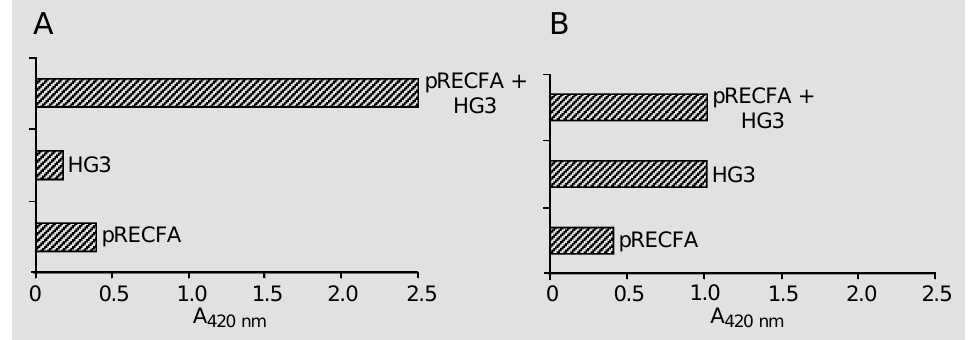
Figure 2 - CFA/I-specific se- creted IgA (sIgA) antibody re- sponse in fecal extracts from mice immunized im with pRECFA as primer and orally boosted with two doses of Sal- monella vaccine strain (HG3) de- tected by IgA-ELISA. The doses of Salmonella vaccine were given two weeks (A) or 54 weeks (B) after the last DNA dose. Mice were immunized with the complete protocol (pRECFA + HG3), two pRECFA doses (pRECFA) or two HG3 doses. Column length indicates the mean of duplicate absorb- ance values of pooled fecal ex- tract samples (N = 5) at 1:4 dilu- tion. Standard deviations were less than 5% of the calculated mean